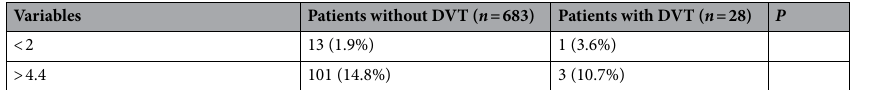
Table 1. Univariate analysis of variables with interest between DVT and non-DVT patients. BMI Body mass index, RBC red blood cell, reference range: Female, 3.5–5.0 × 10 12 /L; males, 4.0–5.5 × 10 12 /L; HCT